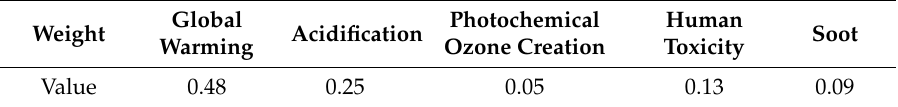
Table 6. Weighting result.